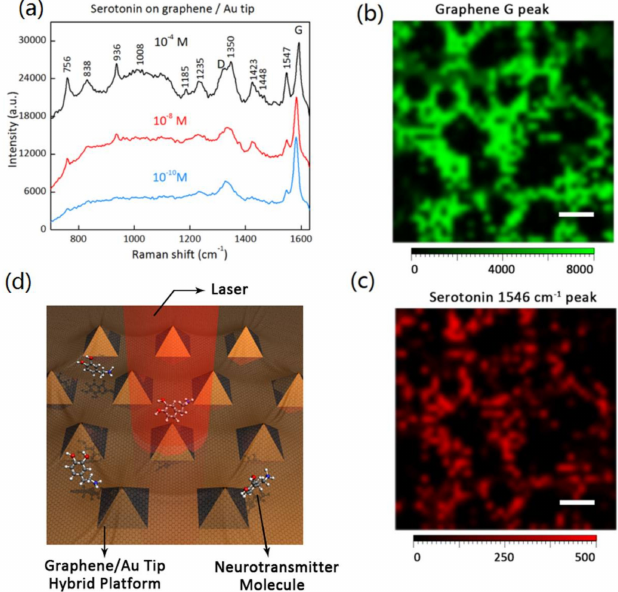
Figure 7. ( a ) Raman spectra of Serotonin molecules on graphene hybrid structure with 3 different concentrations (10 − 4 , 10 − 8 , and 10 − 10 M); ( b , c ) Raman intensity mapping of graphene G band (green) and Raman intensity mapping of serotonin peak at 1546 cm − 1 (red) of the same area, scale bar: 10 µ m; ( d ) Schematic of graphene/Au nanopyramid SERS substrate. Reproduced from [30] with permission;